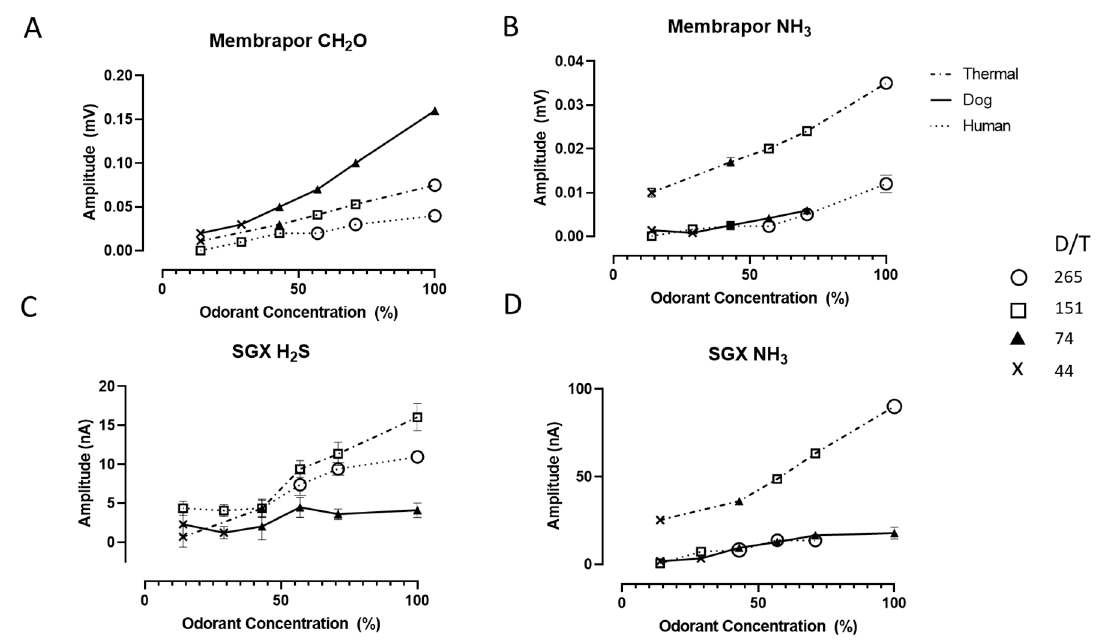
Figure 5. Dose response to three fecal malodor specimens by four sensors, two Membrapor (CH 2 O and NH 3 , A and B ), and two SGX sensors ( C and D ). The dose (%) represents the concentration with respect to the original odor sample. The olfactometry data of each sample (reported as dilution to threshold, or D/T) is indicated by the marker type. Error bars represent the standard deviation.